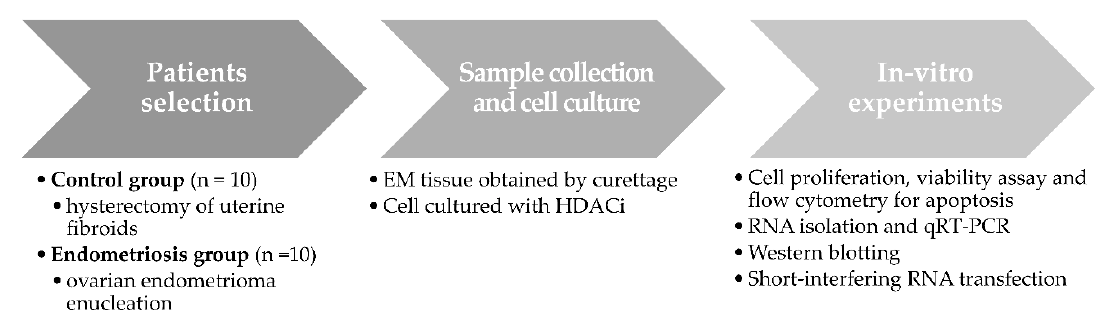
Figure 4. The workflow diagram.